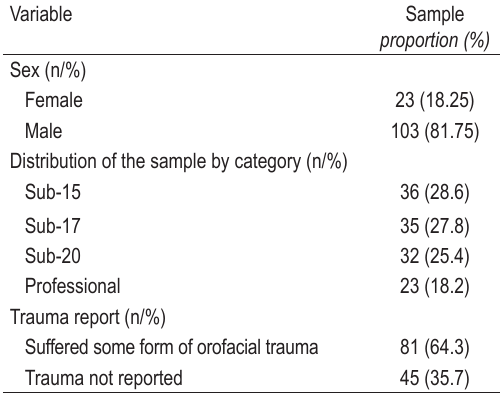
TABLE 1. Characteristics of the sample